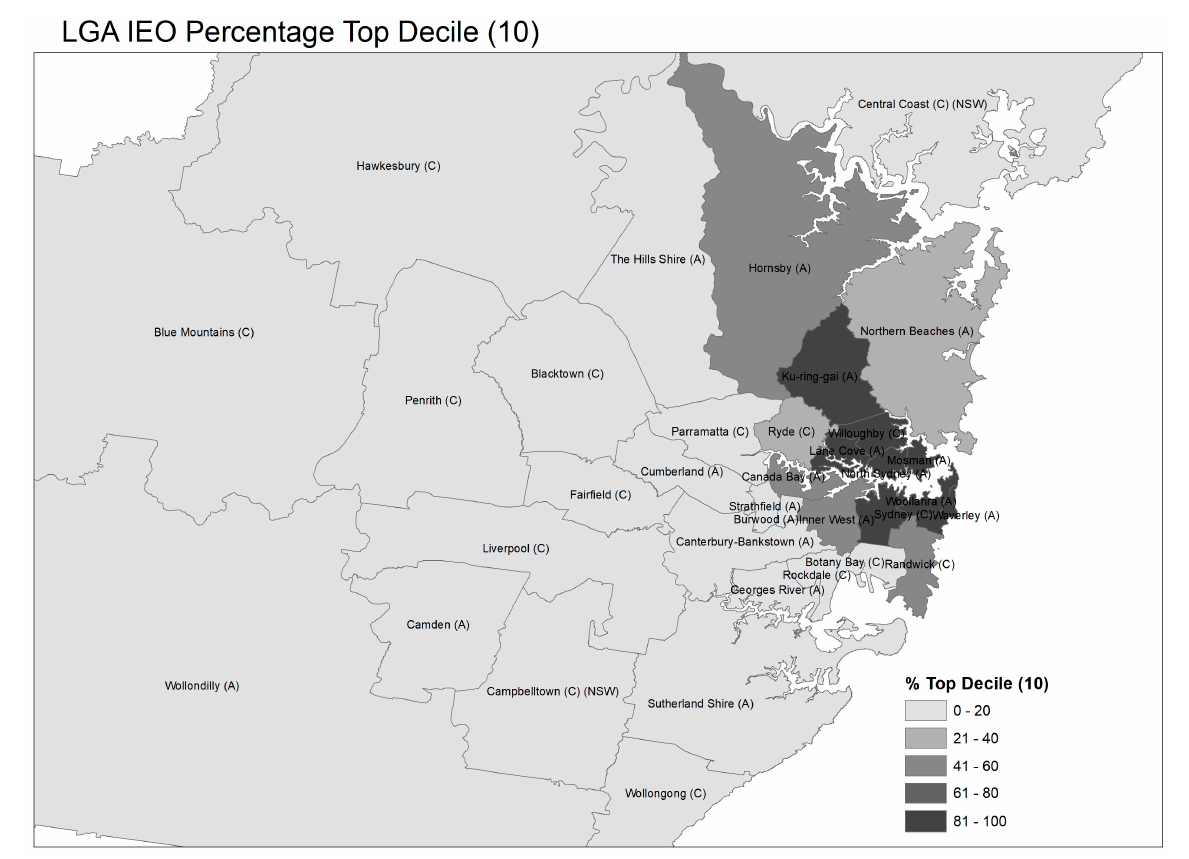
Figure 5. Sydney LGAs IEO percentage (decile 10). Source: authors’ own. Data from the Australian Bureau of Statistics (ABS) 2016 Census.